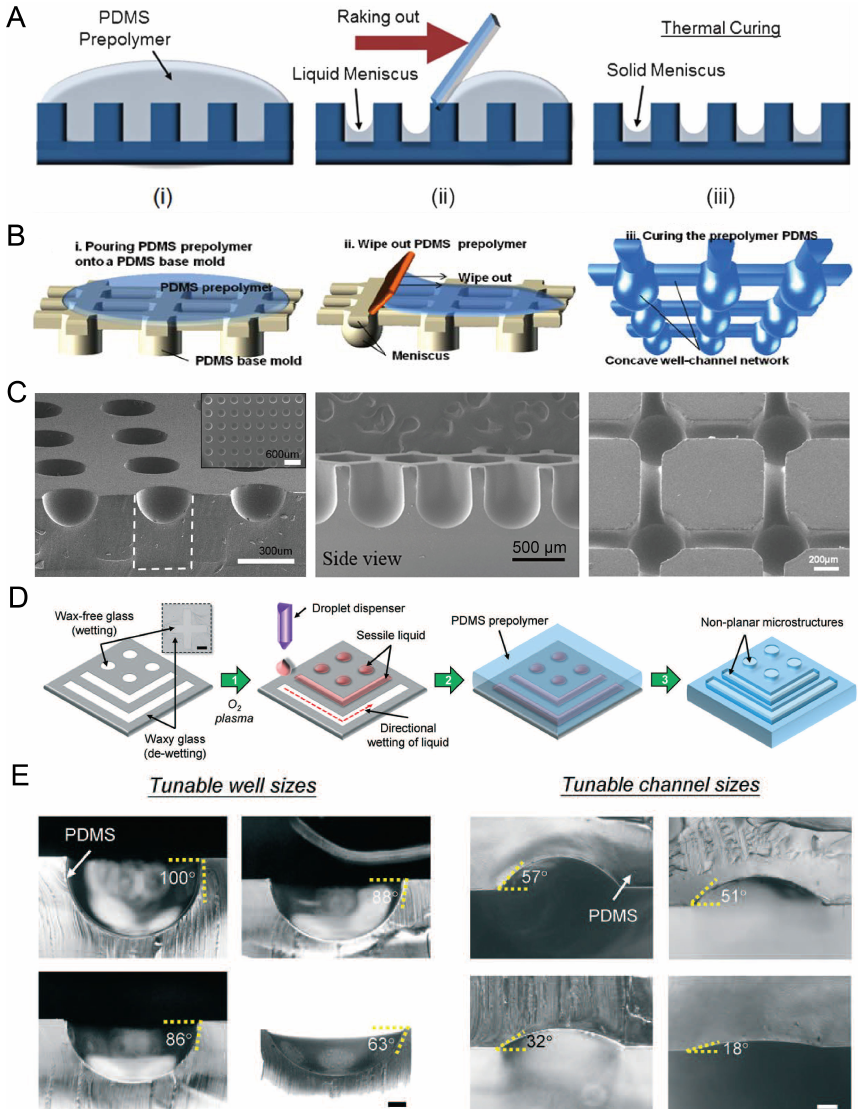
Figure 4. Examples of concave microwell fabrication using surface tension methods. ( A ) PDMS prepolymer was poured on a cured PDMS plate with cylinder microwells, and raked out to form a solid meniscus [46]. Reprinted (adapted) from [46]. Copyright (2013) with permission from Royal Society of Chemistry. ( B ) PDMS prepolymer was poured on a cured PDMS plate to form concave microfluidic well-channel networks [47], and ( C ) SEM pictures of concave microwells and fluidic networks using this method [45,47,50]. Reprinted (adapted) from [47]. Copyright (2014) with permission from Springer Nature. Reprinted (adapted) from [45]. Copyright (2012) with permission from John Wiley and Sons. Reprinted (adapted) from [50] under the terms of the Creative Commons Attribution License. ( D ) Liquid was patterned on glass with wax patterns, and covered by a PDMS prepolymer to form concave wells and channels [53]. ( E ) Concave wells and channels with different dimensions are fabricated using the method described in ( D ) [53]. Scale bar (left): 200 µm, scale bar (right): 100 µm. Reprinted (adapted) from [53]. Copyright (2018) with permission from Royal Society of